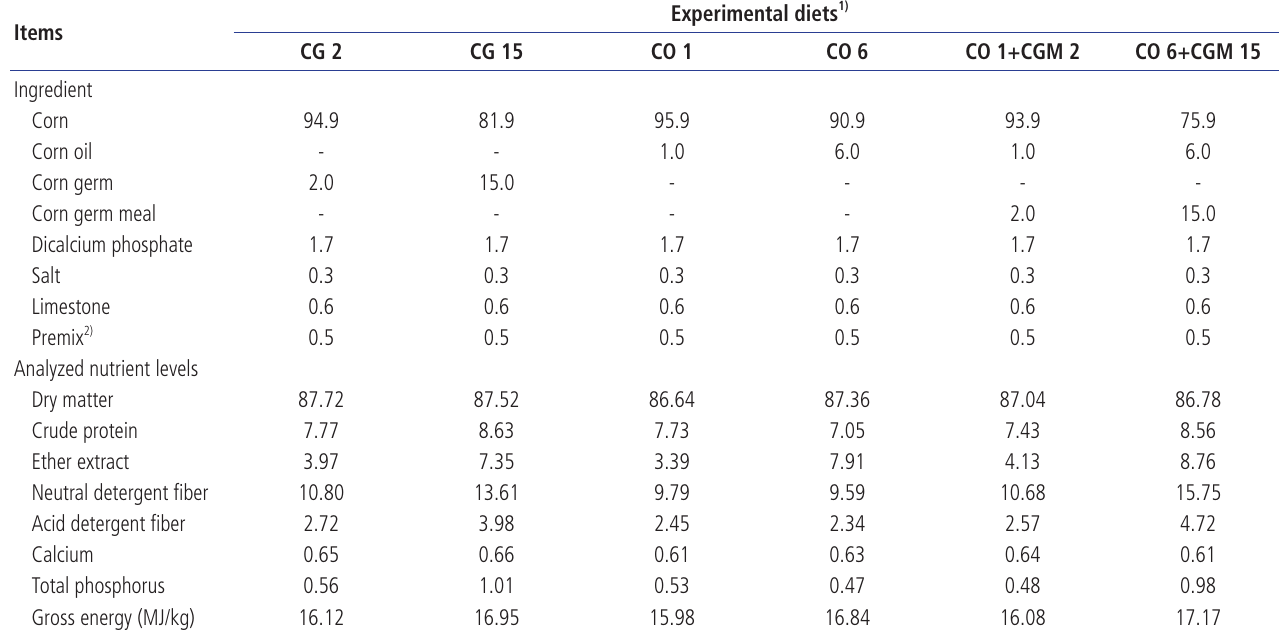
Table 3. Ingredient and analyzed chemical compositons of experimental diets for growing pigs in experiment 2 (%, as-fed basis)